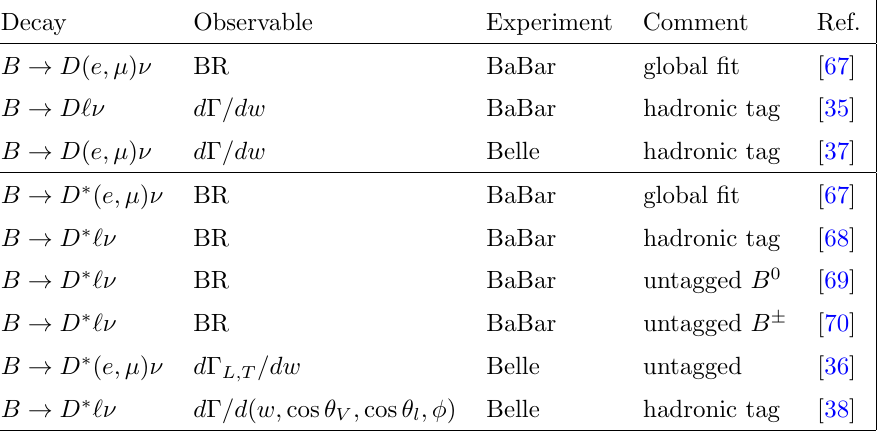
Table 1 . Experimental analyses considered. The analyses labeled by B ate between the lepton species and are hence not used when analyzing scenarios with non-universal